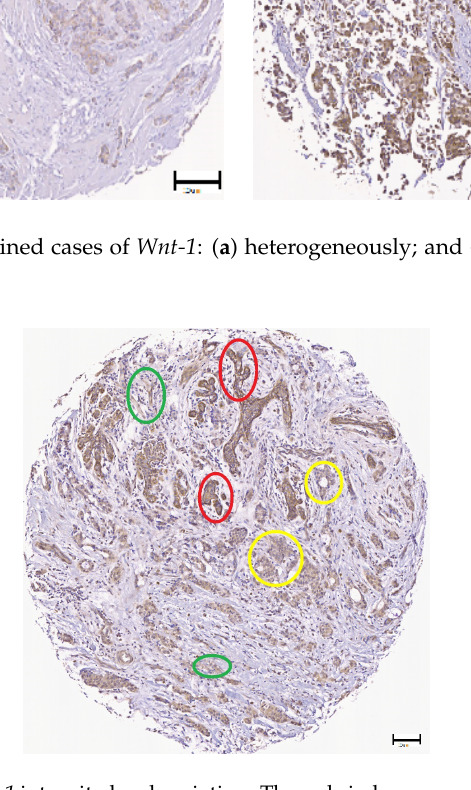
Figure 8. Illustration of Wnt-1 intensity level variation. The red circles correspond to high intensity level examples, the yellow circles correspond to medium level examples and the green circles correspond to low intensity level examples, scale bar = 20 µ